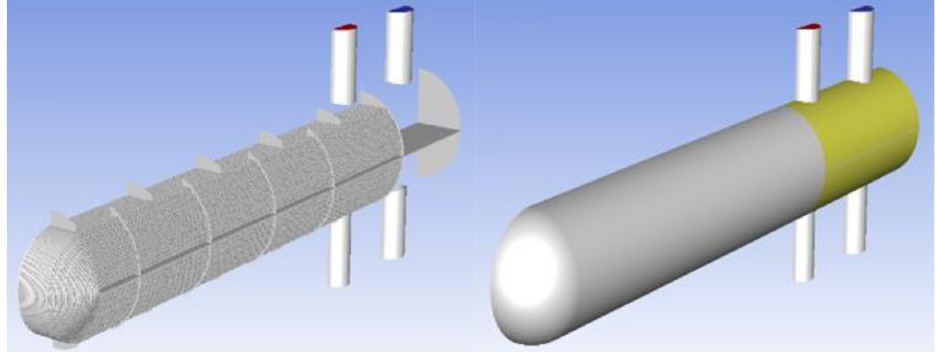
Figure 10. Schematic diagram of heat exchanger model.